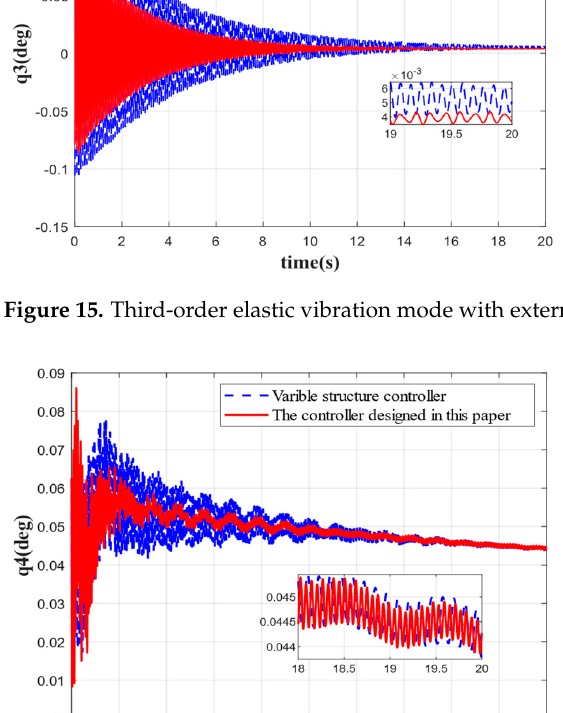
Figure 16. Fourth ‐ order elastic vibration mode with external interference.